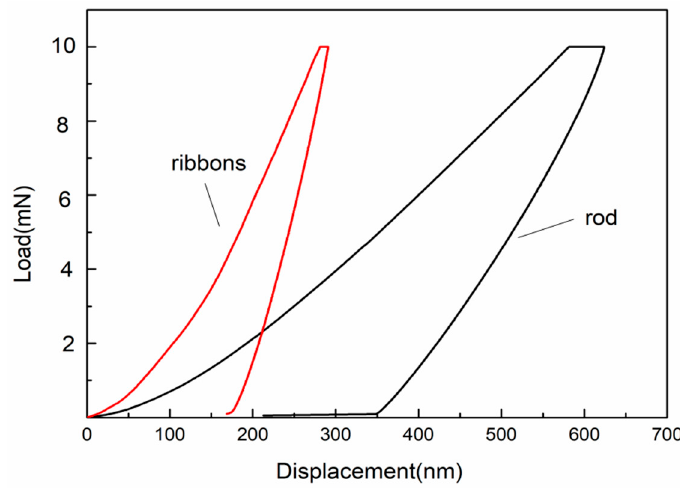
Figure 7. The representative displacement(h)-load(P) for the Ti 40 Zr 40 Ni 20 rod and ribbons.